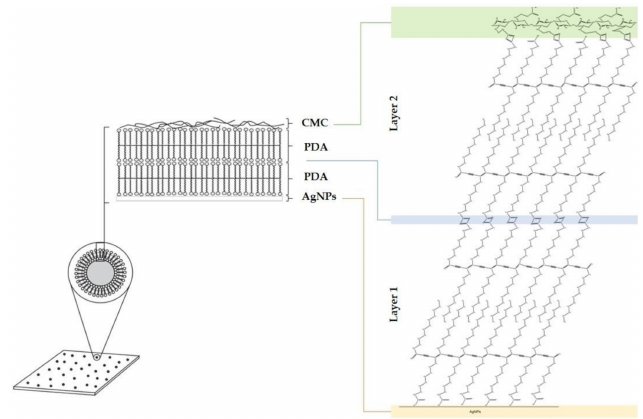
Figure 7. Illustration of interactions between –COOH groups of polydiacetylene (PDA) and silver (Ag)–OH interaction with carboxymethyl cellulose (CMC) at the surface of silver nanoparticles.